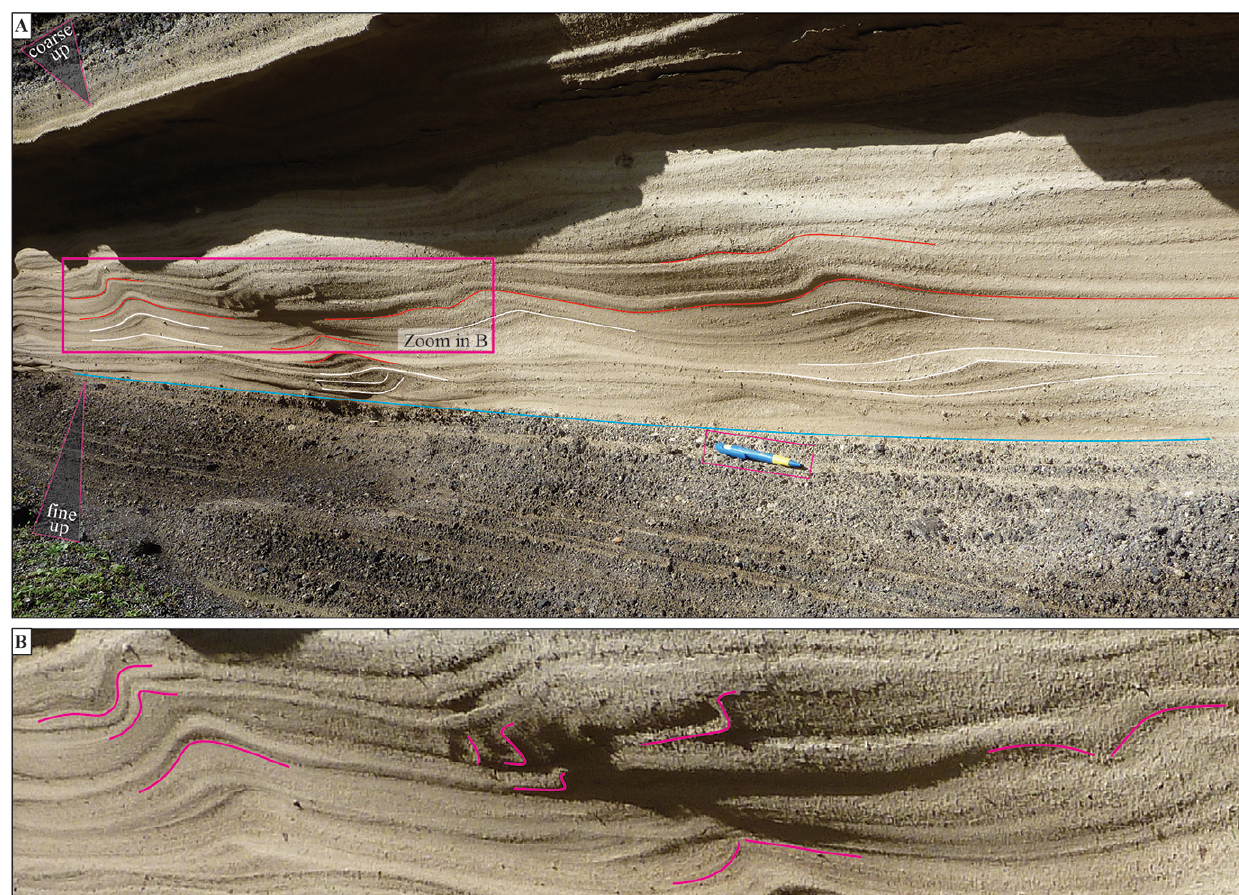
Figure 5. Tower Hill rim: (a) Train of slightly overturned and oversteepened laminations in fine ash bed sets with ripple cross-laminations related to shock waves at the vent. Triangles illustrate grading tendencies reflecting a transition from strombolian to phreatomagmatic explosions. (b) Zoom in oversteepened and slightly overturned